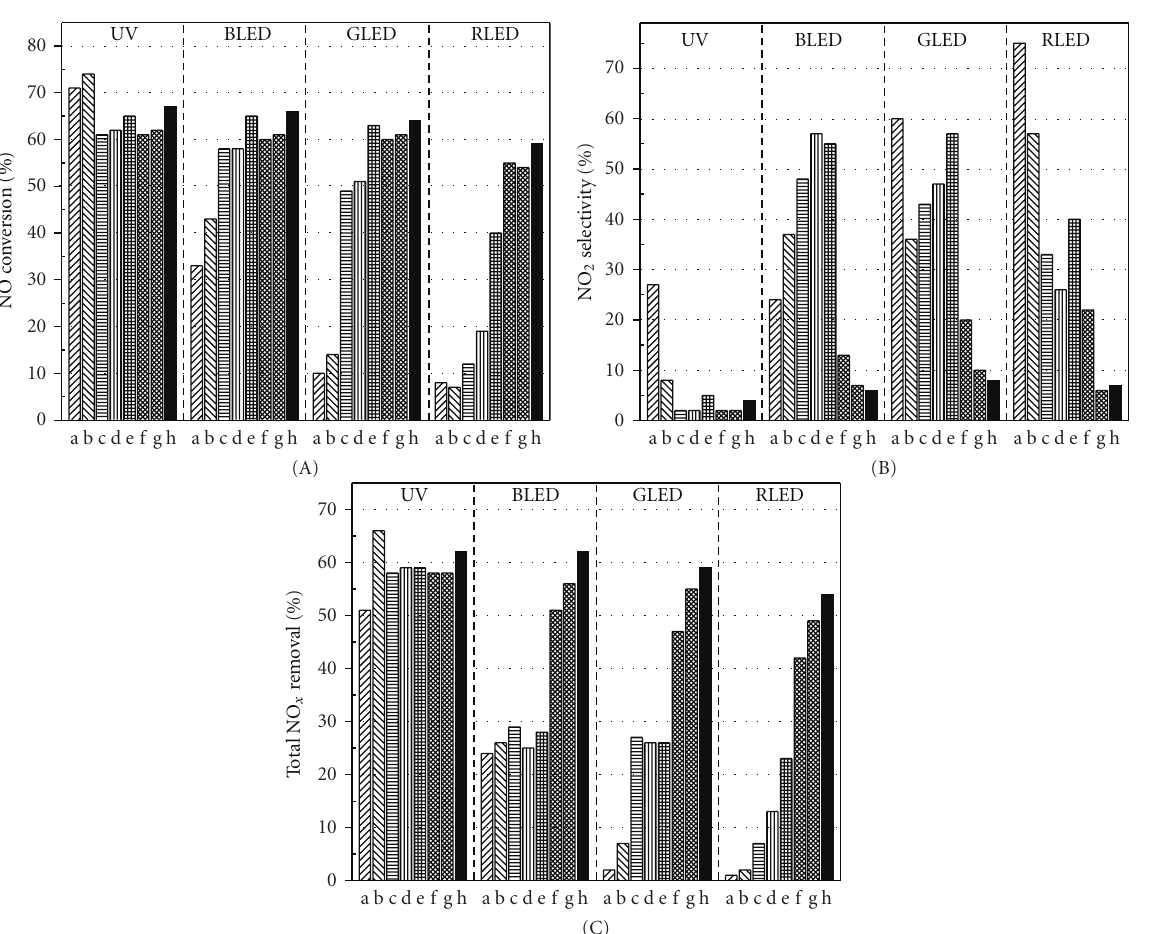
Figure 3: De-NO x activities including NO conversion (A), NO 2 selectivity (B), and total NO x removal (C) on UV100 (a), 2-C3/UV100 (b), C3/UV100 (c), 2-C4/UV100 (d), iC4/UV100 (e), 2-C6/UV100 (f), C6/UV100 (g), and cC6/UV100